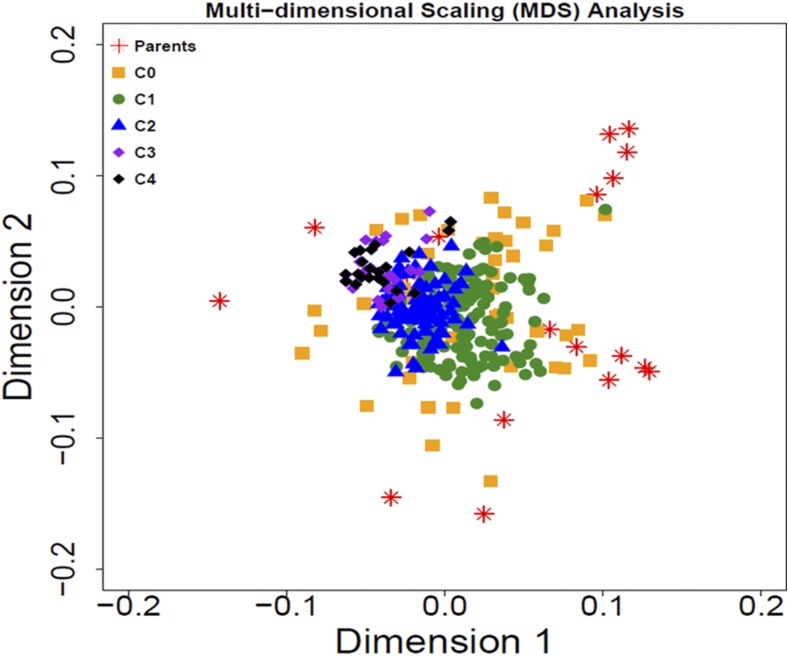
Plot of the two dimensions of the multi-dimensional scaling analysis including all samples of the original parents and families in each cycle.